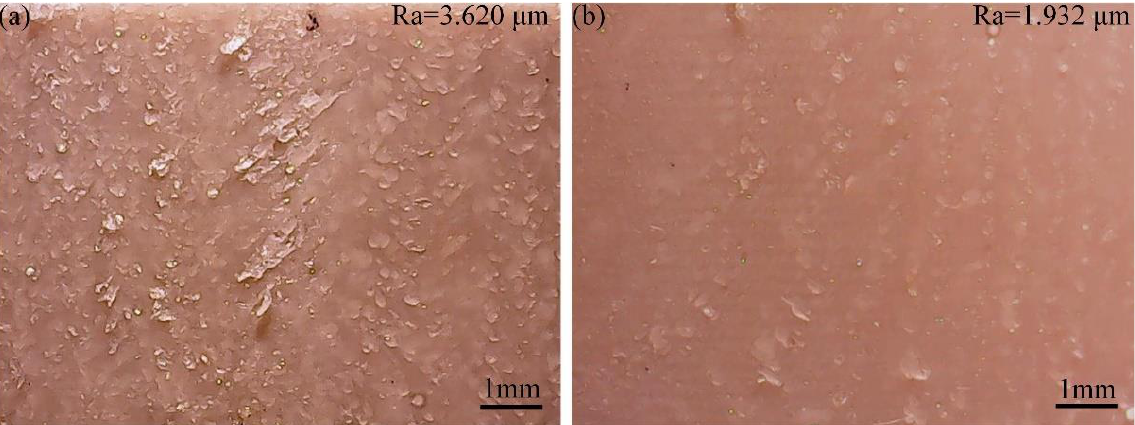
Figure 8. Comparison of surface morphology before and after shear strength optimization: ( a ) before optimization; ( b ) after optimization.